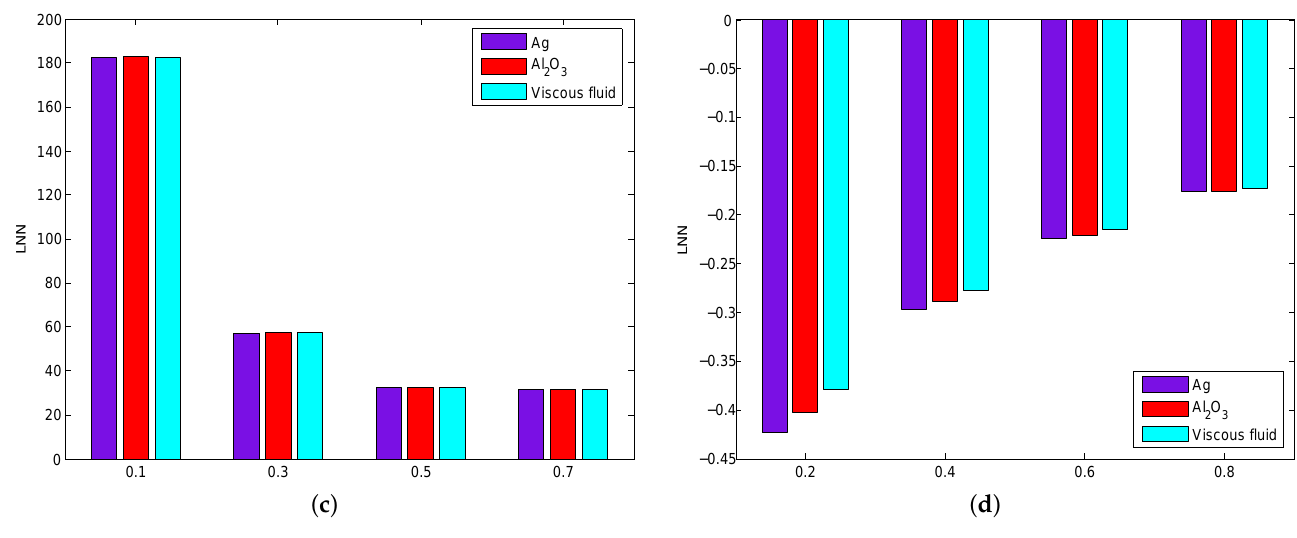
Figure 13. The increasing/declining percentage of LNN on ( a ) A ∗ , ( b ) B ∗ , ( c ) Bi and ( d ) Λ